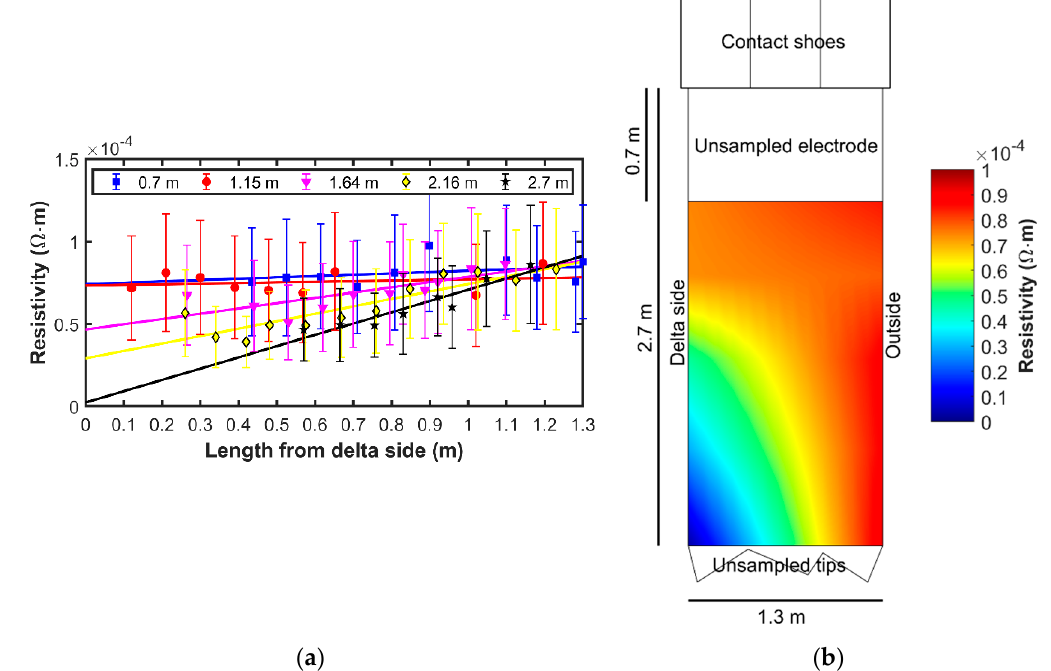
Figure 5. ( a ) Average measured electrical resistivity (markers) and linear fitting of this data (lines), as a function of length below the contact shoes and distance from the delta side of the electrode; ( b ) 3D rendering of the fitted line data associated with resistivities at 10 mm intervals across the electrode at each of the lengths below the contacts shoes indicated in Figure 5(a).